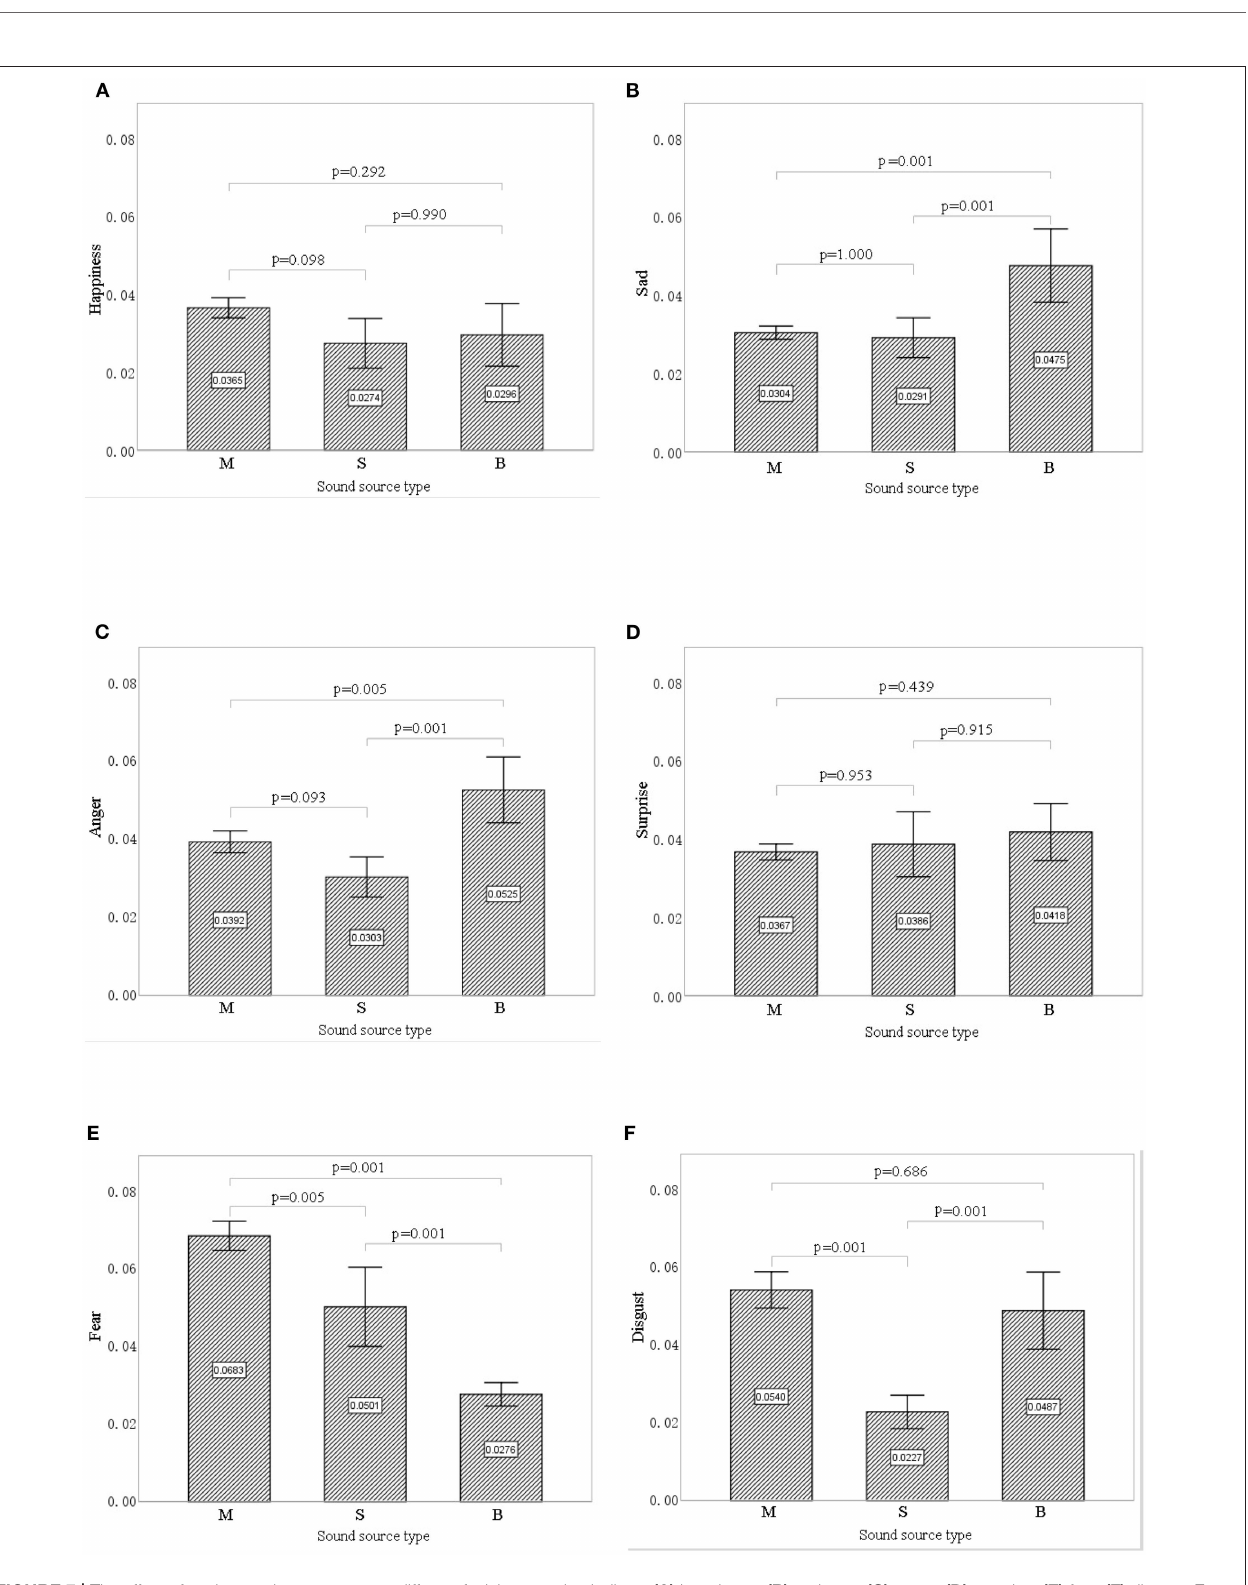
FIGURE 7 | The effect of each sound source type on different facial expression indices: (A) happiness, (B) sadness, (C) anger, (D) surprise, (E) fear, (F) disgust. Error bars show 95% CIs. M, music; S, stream; B, birdsong.